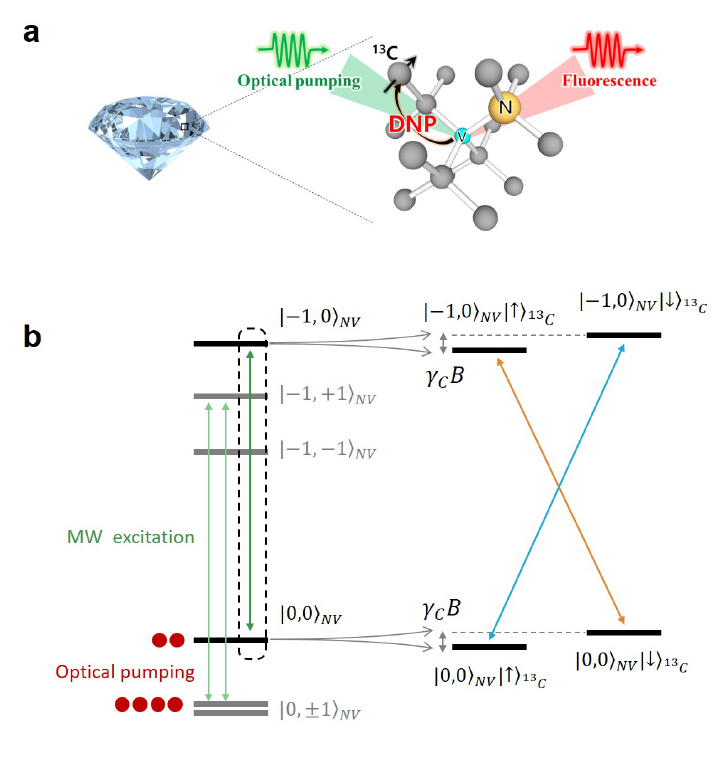
Figure 1. ( a ) The schematic illustration of optical DNP process in diamond. The optically induced polarization in a NV spin transfers to bulk 13 C nuclear spins. ( b ) The part of energy level structure associated with NV, 14 N and distant 13 C spins is given. At a low field, 13 C nuclear Zeeman energy γ c B is weaker than the 14 N hyperfine splitting (2.16 MHz) of NV centers. The arrows indicate possible transitions induced by MW excitation used for the optical